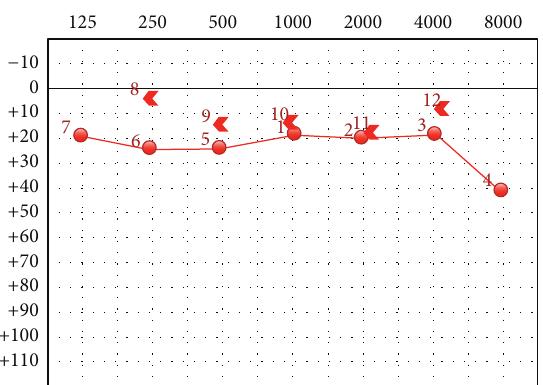
Figure 4: Postoperative audiogram.